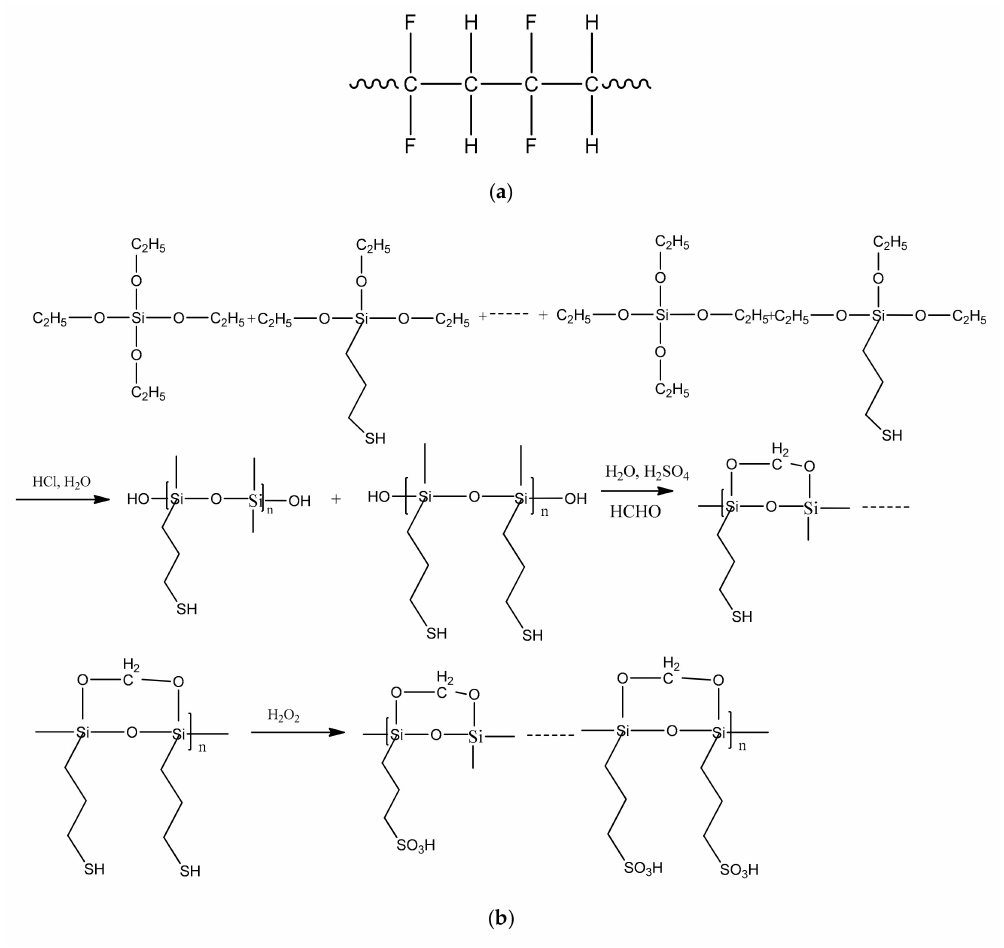
Figure 4. Schematics of the reactions occurring during the synthesis of organic–inorganic hybrid PVDF-SiO 2 membranes: ( a ) polyvinylidene fluoride (PVDF) network chains; ( b ) Hydrolysis polycondensation of TEOS and